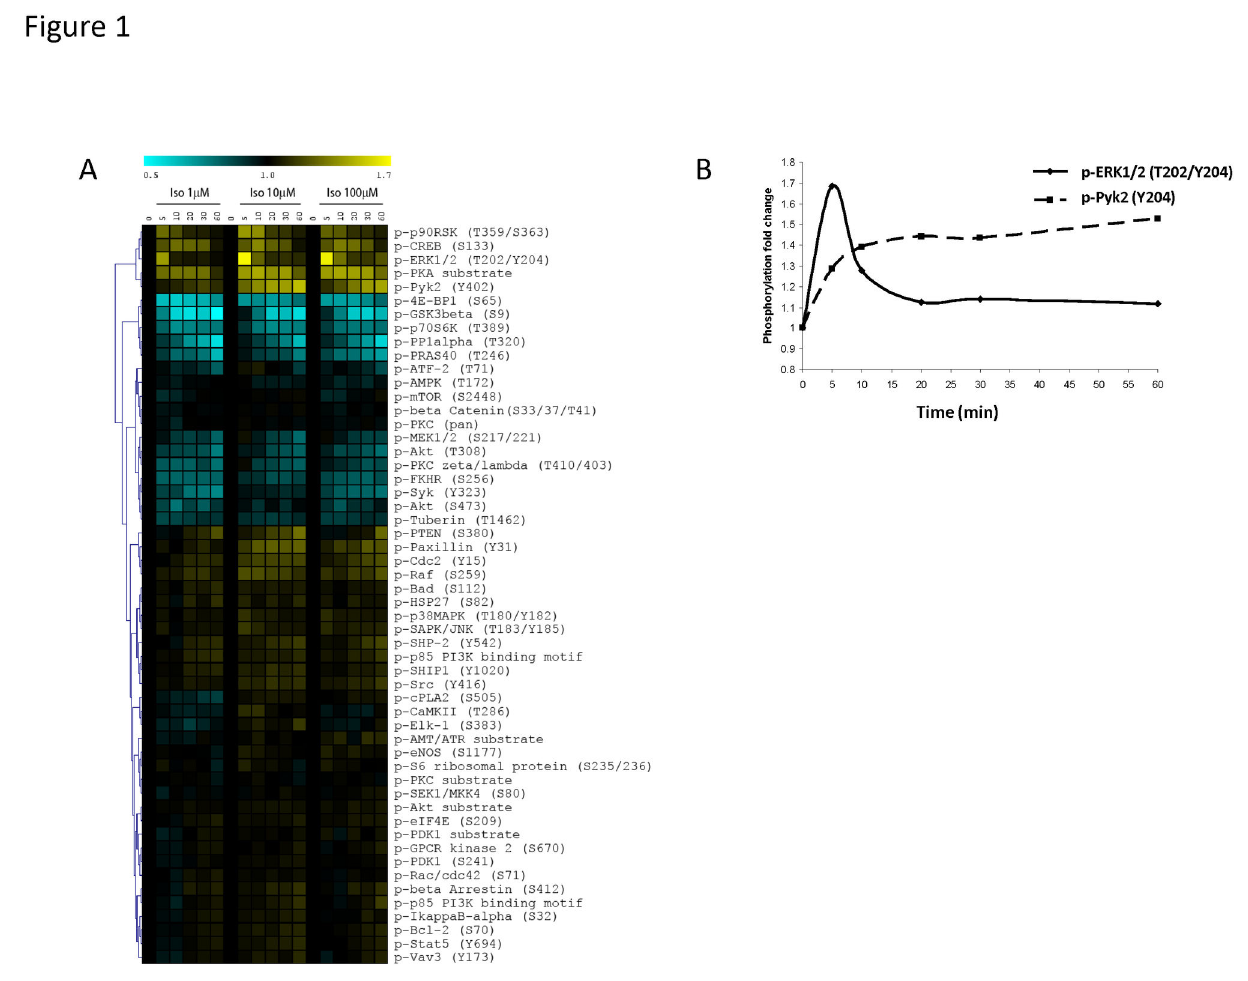
Figure 1. Phosphoprotein signaling in MEFs after stimulation with isoproterenol. A , Heat map representation of phosphoprotein changes over time. MEFs were grown to confluence and then were stimulated with different concentrations of isoproterenol (Iso) (1 μM, 10 μM, or 100 μM) for various times (0, 5, 10, 20, 30, or 60 minutes). Lysate microarrays were used to screen the MEF lysates against a panel of phospho-specific antibodies. Using data from the lysate microarrays, a heat map was constructed that revealed distinct clusters of phosphorylation (yellow) and dephosphorylation (blue) events after isoproterenol stimulation. The color scale shows fold change as compared with unstimulated MEFs. Data are representative of two independent experiments. B , Depiction of ERK1/2(T202/Y204) and Pyk2(Y402) phosphorylation kinetics over a 1 hour time course with isoproterenol (10